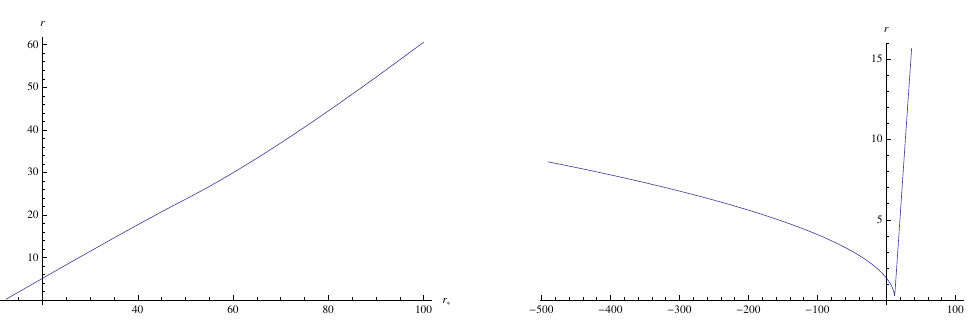
Figure 16 . The radius r for (cid:20)m 0 ’ (cid:20) ^ m 0 ’ 0 : 00227 (left) and that for (cid:20)m 0 = 0 : 00226 (right). For (cid:20)m 0 = 0 : 00227, it approaches to zero but the numerical di(cid:14)culty arises around r ’ 0 : 22, while the turning point of r for (cid:20)m 0 = 0 : 00226 is slightly outside of this point: r ’ 0 : 24.